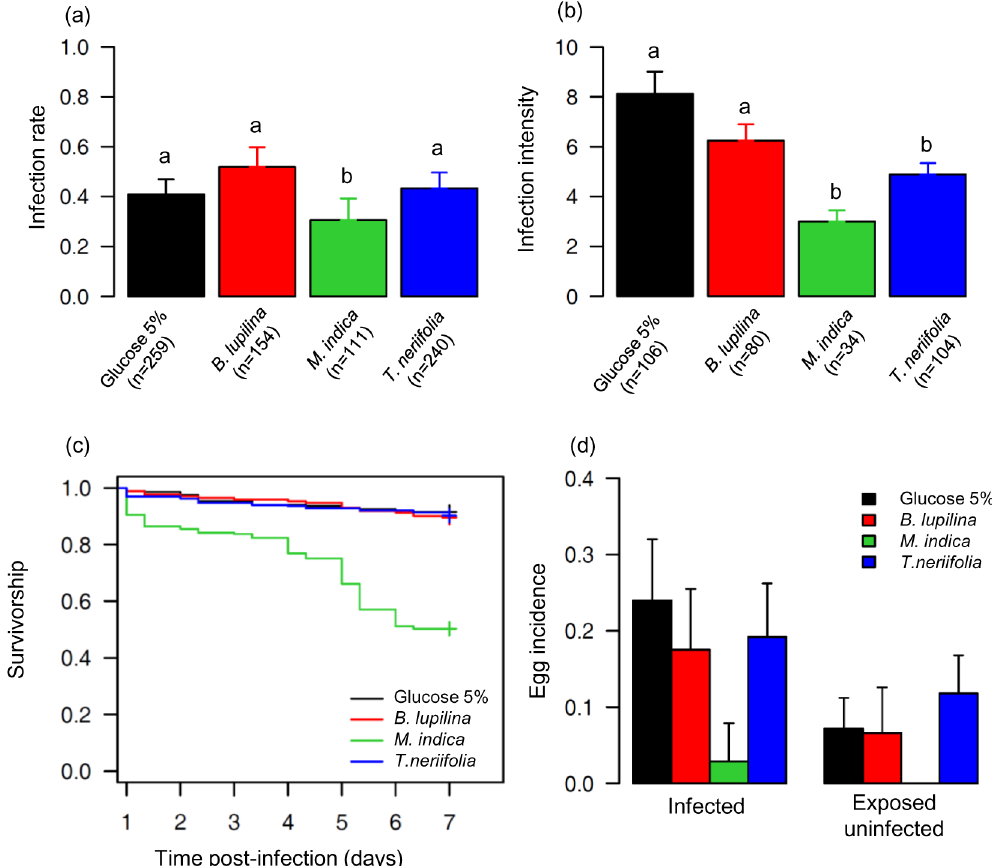
Fig 1. Effect of sugar treatment on the early development of P . falciparum , and on the survival and fecundity of malaria-exposed Anopheles coluzzii . (a) Infection rate ( ± 95% CI), expressed as the proportion of mosquitoes exposed to an infectious blood meal and harboring at least one oocyst in their midgut, over 4 replicates and using a total of 7 gametocyte carriers. Numbers in brackets indicate the total number of mosquitoes dissected 7 days post infection (dpi) for each sugar treatment. Different letters above the bars denote statistically significant differences based on multiple pair-wise post-hoc tests. (b) Infection intensity ( ± se), expressed as the mean number of developing oocysts in the guts of infected females, over 4 replicates and using a total of 7 gametocyte carriers. Numbers in brackets indicate the total number of infected mosquitoes for each sugar treatment. Different letters above the bars denote statistically significant differences based on multiple pair-wise post-hoc tests. (c) Survivorship of malaria-exposed mosquitoes for each sugar treatment over 4 replicates and using a total of 7 gametocyte carriers. Survival was recorded twice a day from 1 to 7 dpi. (d) Egg incidence ( ± 95% CI) of malaria- exposed mosquitoes, expressed as the proportion of mosquito females carrying fully matured eggs inside their ovaries on 7 dpi for each sugar treatment and infection